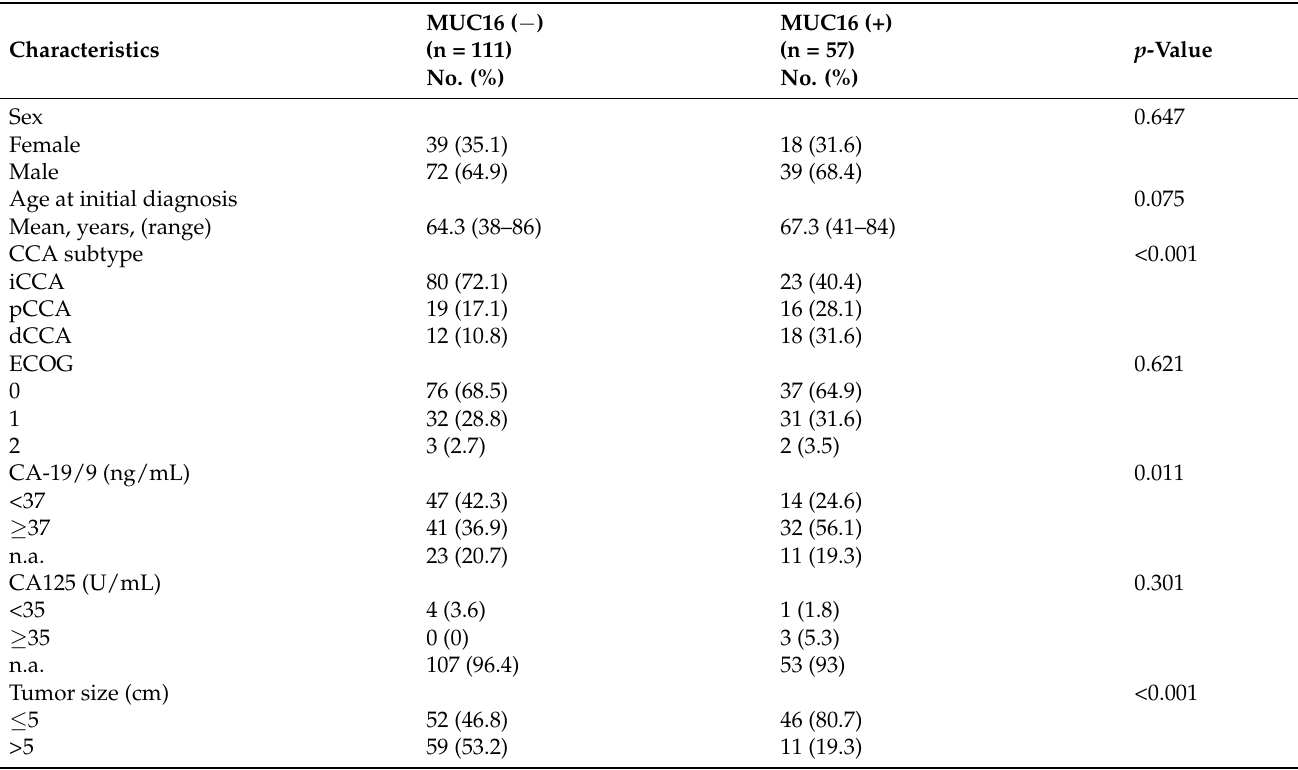
Table 1. Baseline characteristics of MUC16 (+)/( − ) CCA patients.